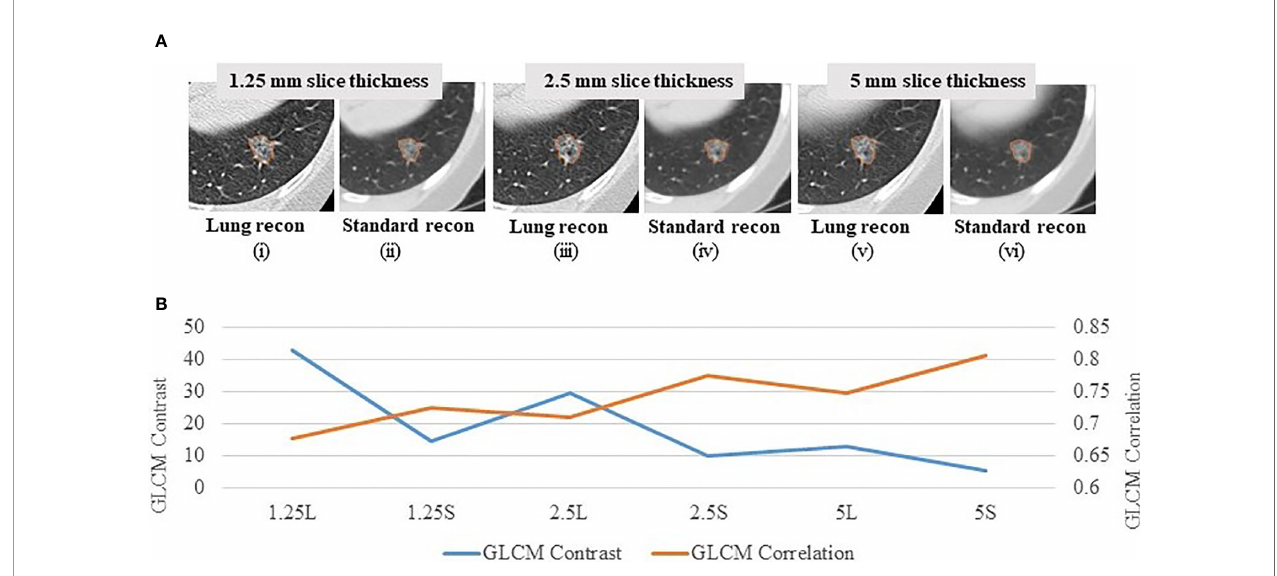
FIGURE 3 | Effects of imaging parameters on radiomics features (A) A lung tumor captured on one CT scan reconstructed at 6 different imaging settings: 1.25 mm slice thickness with the lung reconstruction algorithm (sharp image) (1.25L) (i) and the standard reconstruction algorithm (smooth image) (1.25S) (ii); 2.5 mm slice thickness with lung reconstruction (2.5L) (iii) and standard reconstruction (2.5S) (iv); 5 mm slice thickness with lung reconstruction (5L) (v) and standard reconstruction (5S) (vi) (31). (B) GLCM Contrast (blue color) and Correlation (orange color) features computed at the 6 corresponding imaging reconstruction settings. The bigger the value of Contrast, the more heterogeneous the tumor. The greater the value of Correlation, the more homogeneous the tumor.